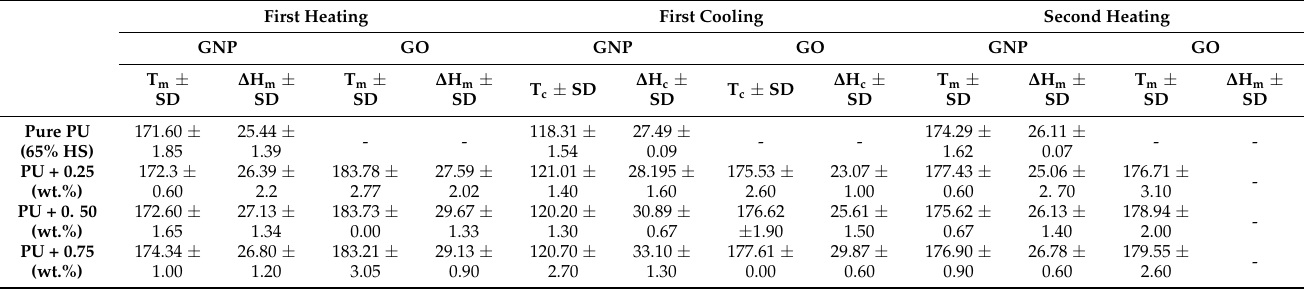
Table 2. Thermal transitions of PU/GNP and PU/GO nanocomposites compared to pure